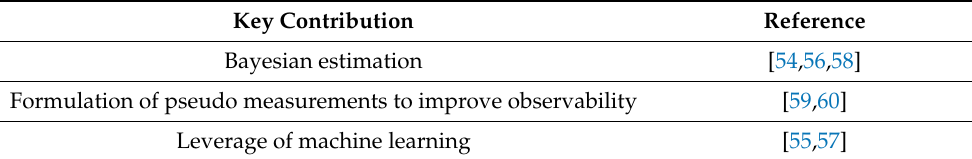
Table 2. Summary of